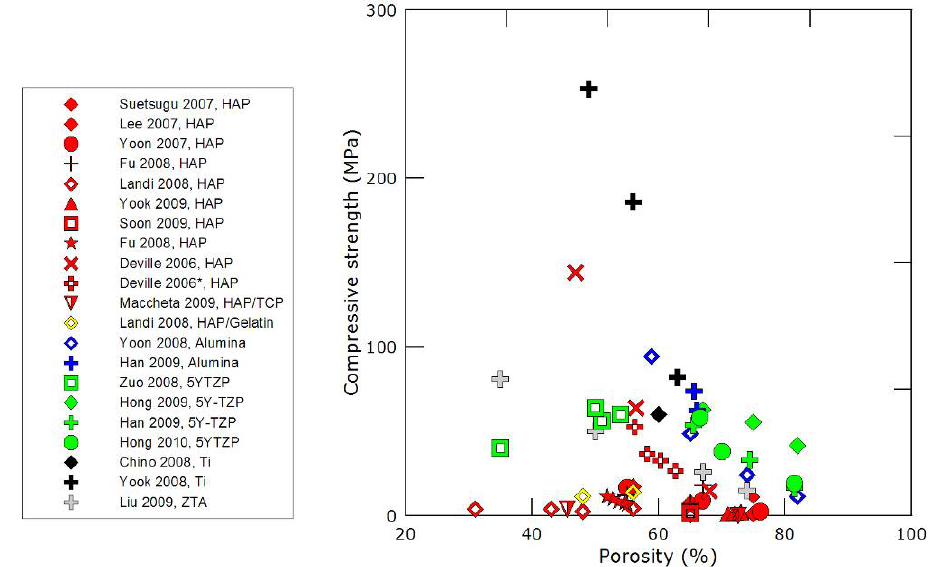
Figure 7. Compressive strength values versus material porosity percentage from literature